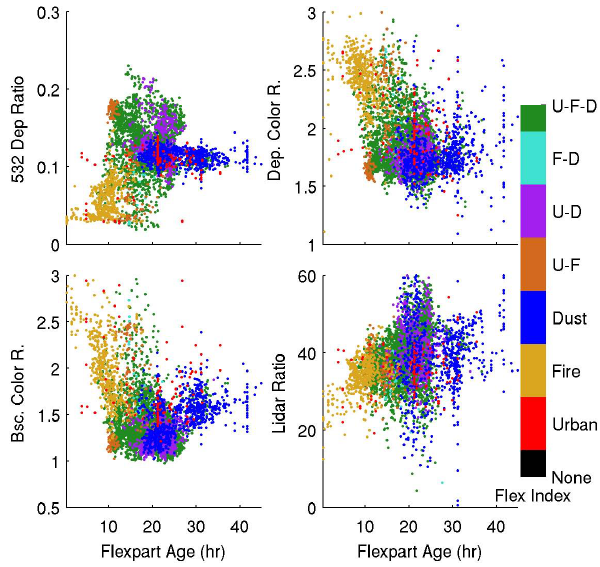
Fig. 12. Scattergram of HSRL intensive aerosol properties ver- sus particle age simulated with Flexpart for the plume section on 13 March shown in Fig. 11. Points colored using Flexpart Particle Index